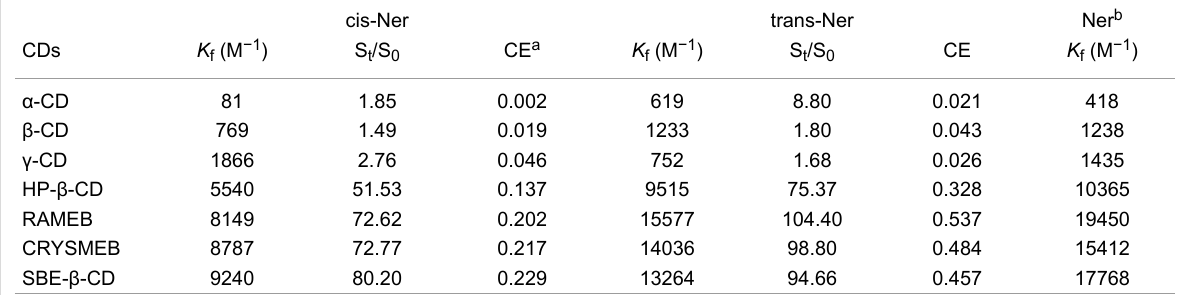
Table 1: Formation constants ( K f ), solubility enhancement ratio (S t /S 0 ) (in the presence of 10 mM CD, except for β -CD and γ -CD, 1mM) and complex- ation efficiency (CE) of cis and trans -Ner with different